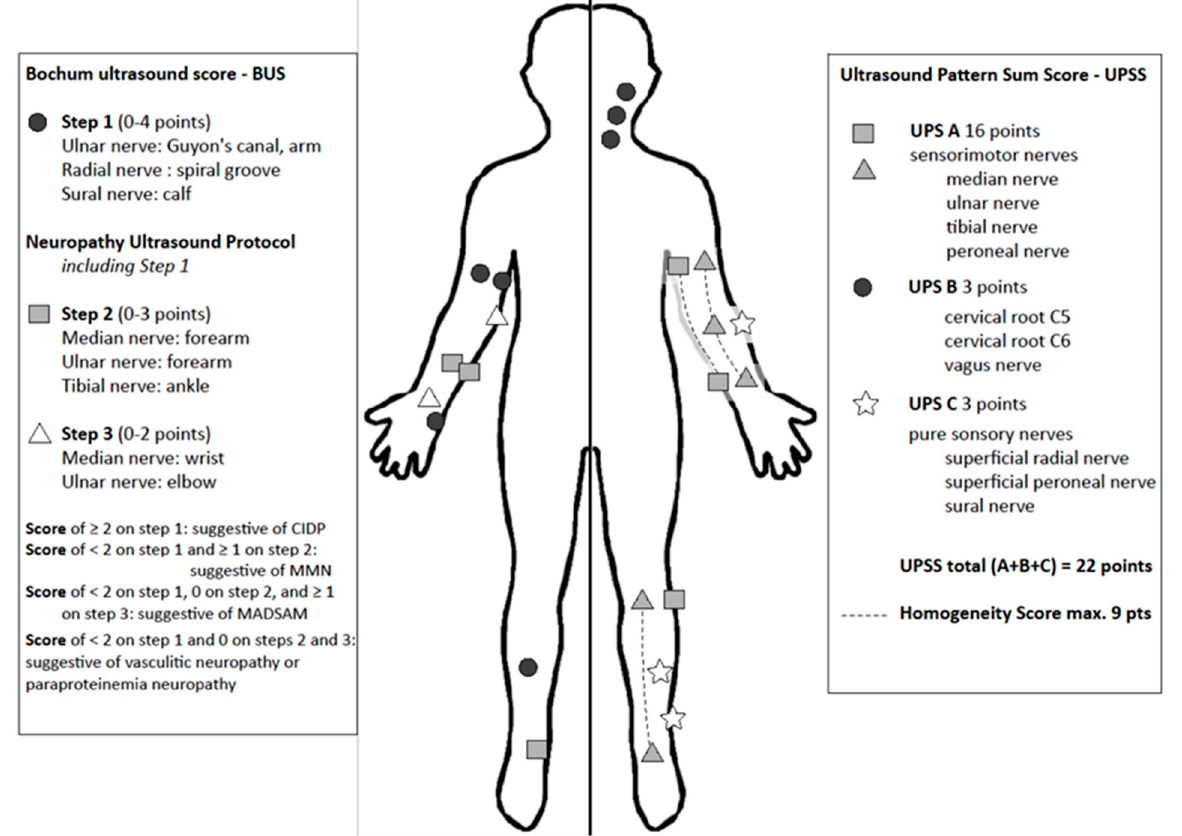
Figure 5. Measure points and scoring system of Bochum Ultrasound Score (BUS, left side), Neuropathy Ultrasound Protocol (NUP) and Ultrasound Pattern Sum Score (UPSS, right side). BUS and NUP are applied in three steps according to number of enlarged nerves. UPSS is performed in one step and the addition of homogeneity score allows differentiation of nerve in homogenous or heterogenous enlargement patterns.